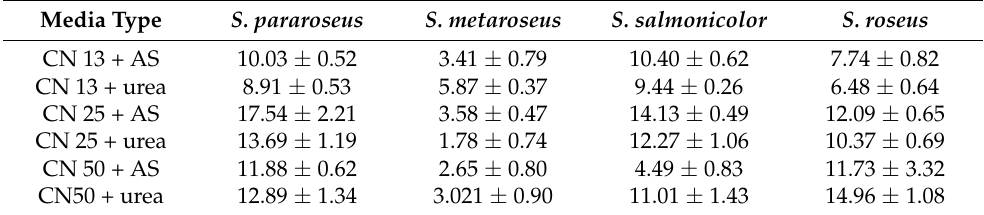
Table 5. Yeast biomass production in screening cultivations on SCG hydrolysate. Biomass production is listed in g/L of